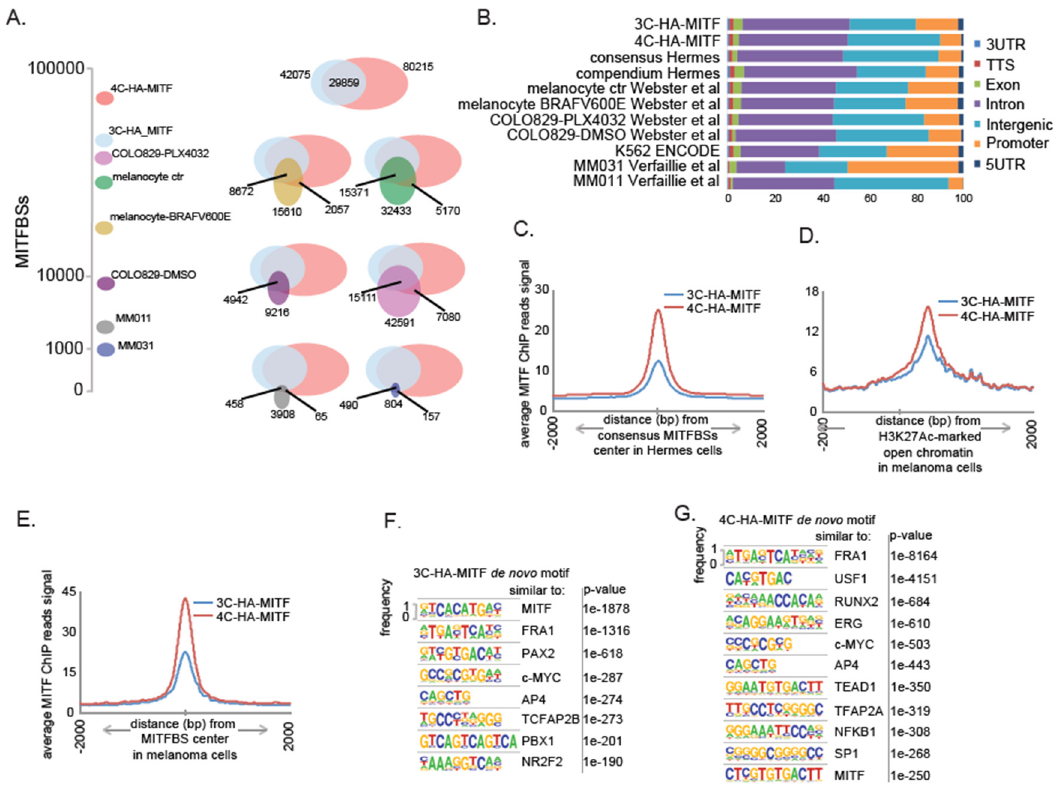
Figure 3. HA-MITF-M enhances the chromatin binding and reprograms transcription. ( A ) MITF binding sites (MITFBSs) number in Hermes 3C-HA-MITF and Hermes 4C-HA-MITF and overlap with the indicated datasets. MITFBSs in COLO829 and Melanocytes data are from Webster et al. [41], MITFBSs in Melanoma cell lines MM011 and MM031 are from Verfaillie et al. [38]. ( B ) Distribution of MITF binding sites (MITFBSs) according to annotated genomic region. From this study and publicly available datasets as indicated. ( C ) Distribution analysis of MITF ChIP-seq reads in 3C-HA-MITF and 4C-HA-MITF cells around consensus MITF binding sites (MITFBSs) in Hermes cells. ( D ) Distribution analysis of MITF ChIP-seq reads in 3C-HA-MITF and 4C-HA-MITF cells around high confidence open chromatin marked with H3K27Ac in 12 melanoma cell lines from Verfaillie et al. [38] (see Methods). ( E ) Distribution analysis of MITF ChIP-seq reads in 3C-HA-MITF and 4C-HA-MITF cells around high-confidence MITFBSs retrieved from the melanoma cell line COLO829 and transformed Melanocyte through forced expression of BRAFV600E from Webster et al. [41] (see Methods). ( F ) De novo motif discovery analysis using 42,075 MITFBSs’ DNA sequences retrieved from 3C-HA-MITF cells. ( G ) De novo motif discovery analysis using 80,215 MITFBSs’ DNA sequences retrieved from 4C-HA-MITF cells.